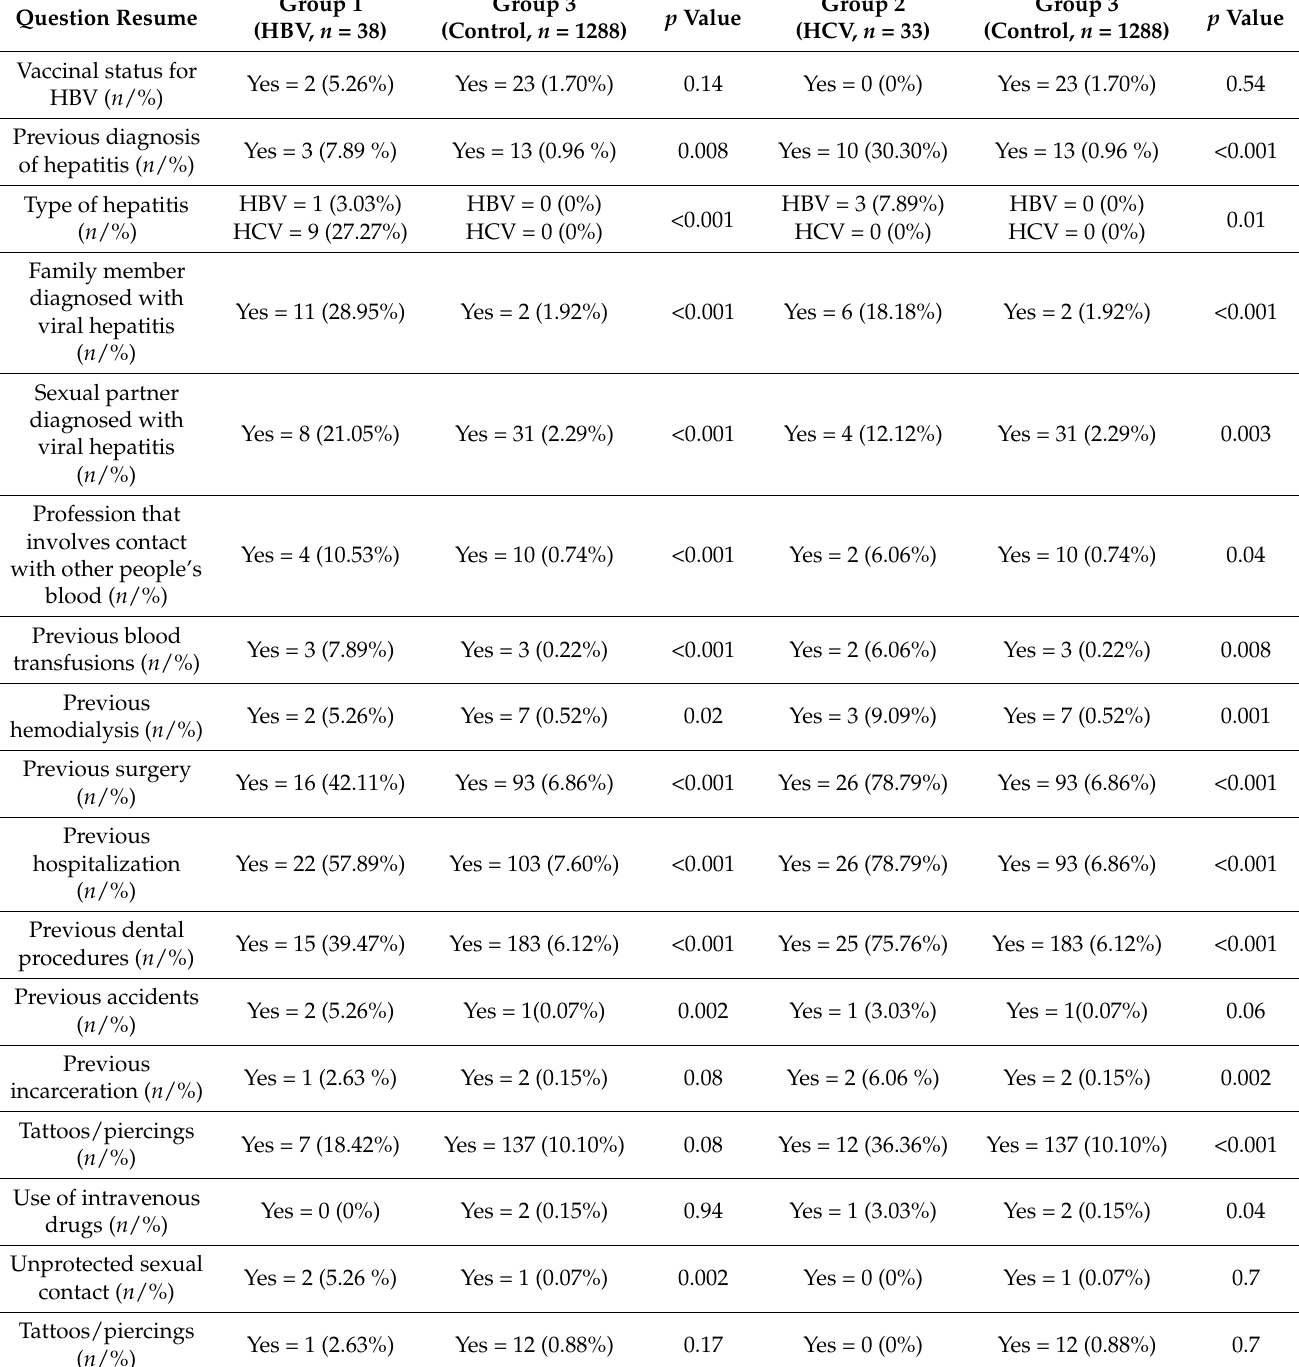
Table 2. Clinical characteristics of the patients included in the main